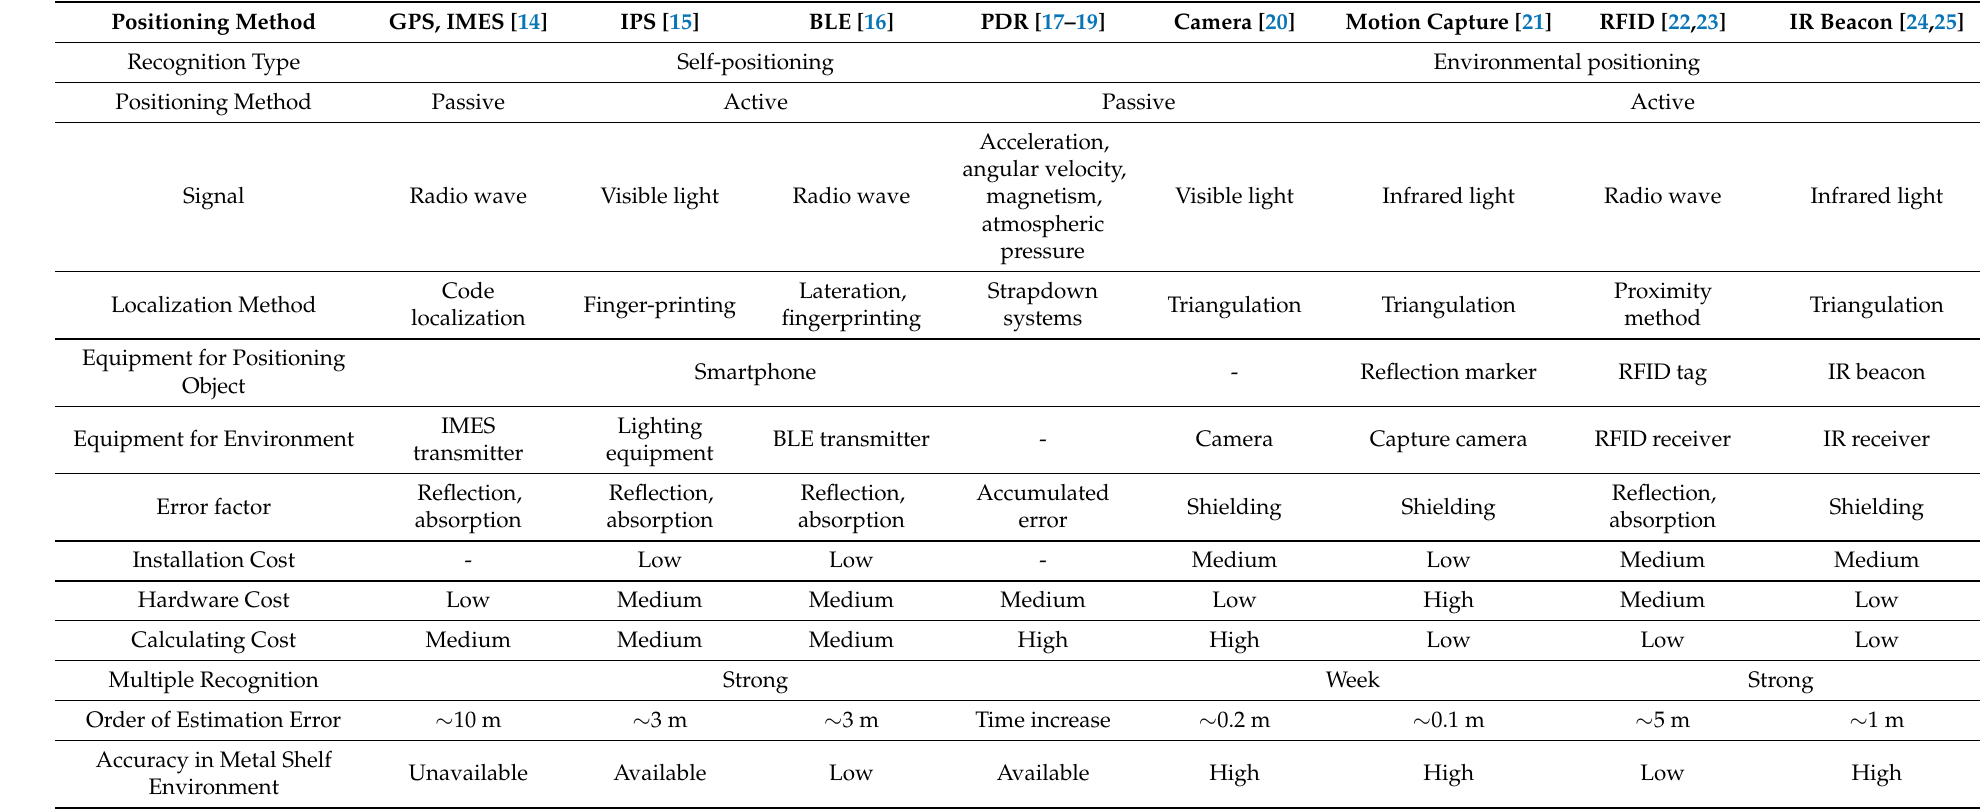
Table 1. Comparison of popular indoor positioning